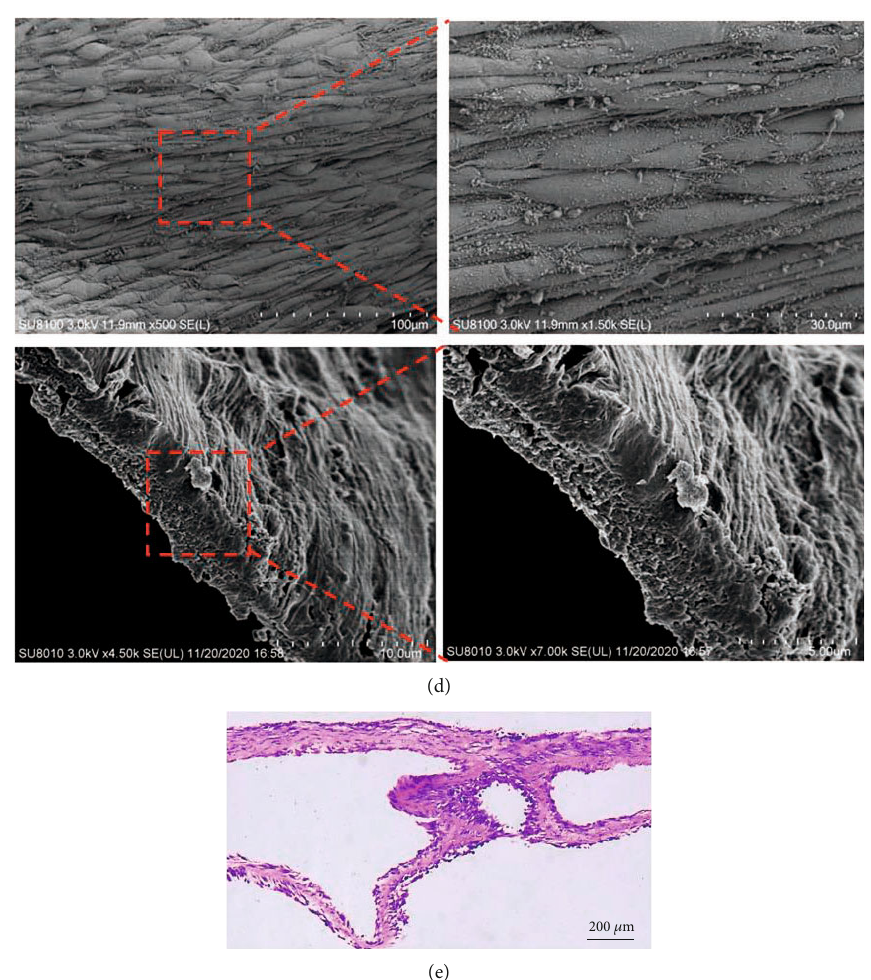
Figure 4: Preparation and characterization of hAMSCs sheet. (a) Gross appearance of the hAMSC sheet derived from hAMSCs and the cell sheet could be folded to an oblong-shaped fl ap. (b) hAMSC sheet was observed under inverted phase contrast microscope. Many long spindle-shaped cells were closely arranged and evenly distributed. (c) Live/dead staining of the cell sheet. Green indicated live cells and red indicated dead cells. (d) SEM of cell sheet. Cells were embedded in a large amount of extracellular matrix secreted by themselves. (e) Histological analysis (HE staining) of the harvested cell sheet that was composed of multilayer cells and vast